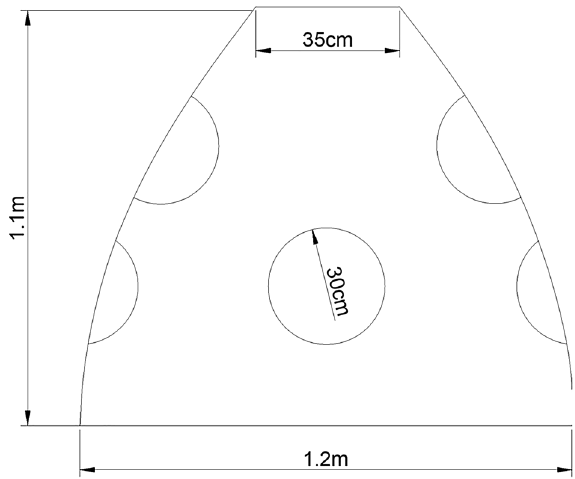
Figure 4. ( A ) Partial least squares Discriminant Analysis (PLS-DA) plots of microbial communities of the three treatments plus the natural reef from the three localities over the three seasons, based on Bray–Curits distances. ( B , C ) Principal Component Analysis (PCA) of the different treatments based on ASVs and species